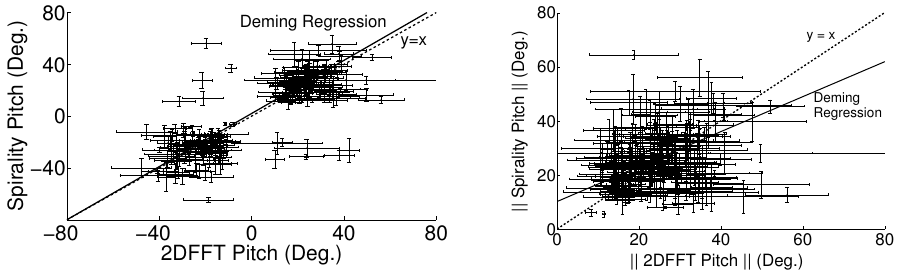
Figure 8. Spirality measurements vs. 2DFFT measurements of visually selected spirals in the GOODS North and South samples. For each plot, the solid line represents the orthogonal least squares (Deming) regression, while the dashed line represents y = x . Left panel : all 203 visually selected spirals. Right panel , absolute values for the 191 galaxies for which Spirality and 2DFFT agree on